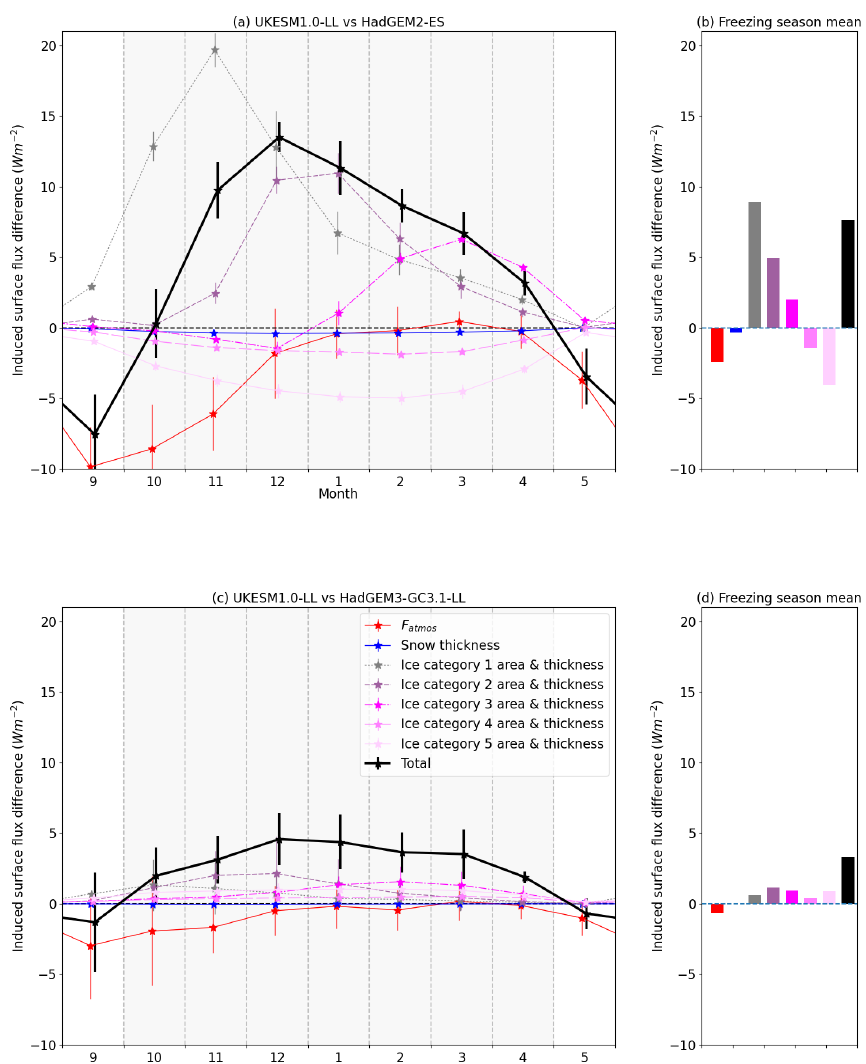
Figure 7. Illustration of drivers of winter freezing differences, using the ISF framework. Shown are ISF freezing season differences due to atmospheric forcing, snow thickness and ice thickness for (a, b) UKESM1.0-LL relative to HadGEM2-ES and (c, d) UKESM1.0-LL relative to HadGEM3-GC3.1-LL, showing September–May monthly evolution (left column) and freezing season mean (right column, October– April). For (a) and (c) , the bars denote ensemble mean and standard